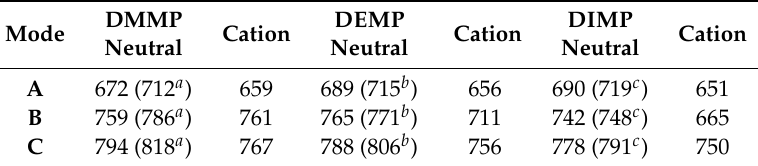
Table 2. Computed vibrational energies of DMMP, DEMP, and DIMP in cm − 1 . Experimental